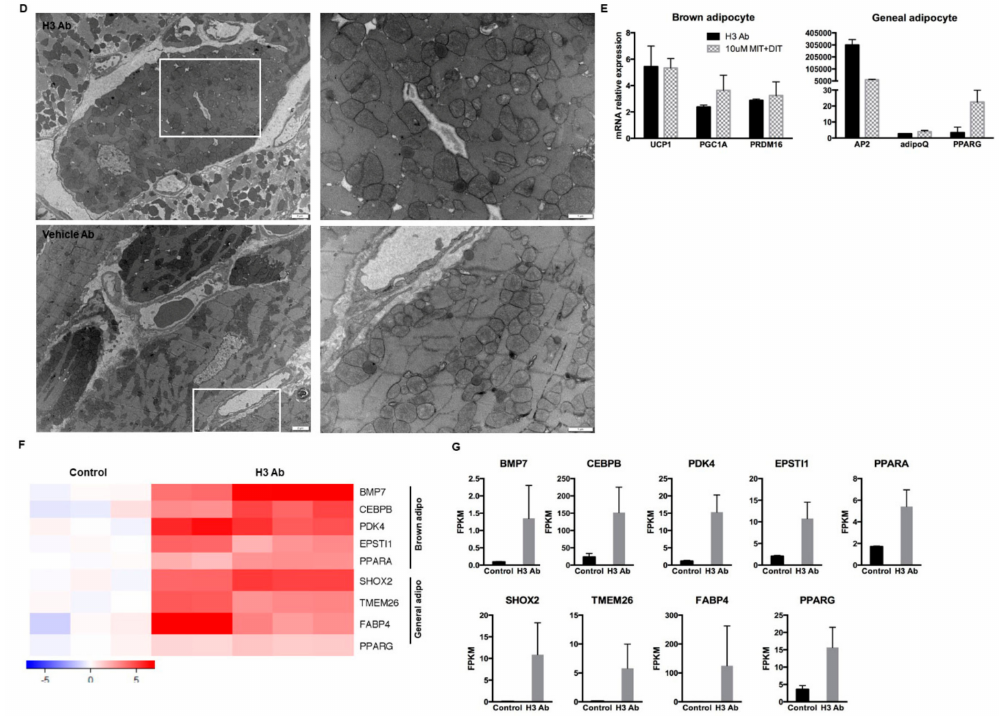
Figure 3. H3 antibody di ff erentiates human CD34 + cells into brown adipocyte-like cells. ( A ) Human CD34 + hematopoietic stem cells that were treated with H3 antibody for 2 weeks in vitro di ff erentiated into brown adipocyte-like cells. The white box indicates the region magnified in the insert. Red arrows point to adipocyte-like cells (Magnification: 20 × ). ( B ) Human CD34 + cells treated in vitro for 2 weeks with purified H3 Ab stained positive for large lipid droplets (Magnification: 20 × ) and expressed brown adipocyte marker UCP1 as confirmed by flow cytometry. ( C ) To show migration of the adipocyte-like cells from the bone marrow to the heart, H3 Ab (50 µ g / mouse, i.p., two times / week) was injected